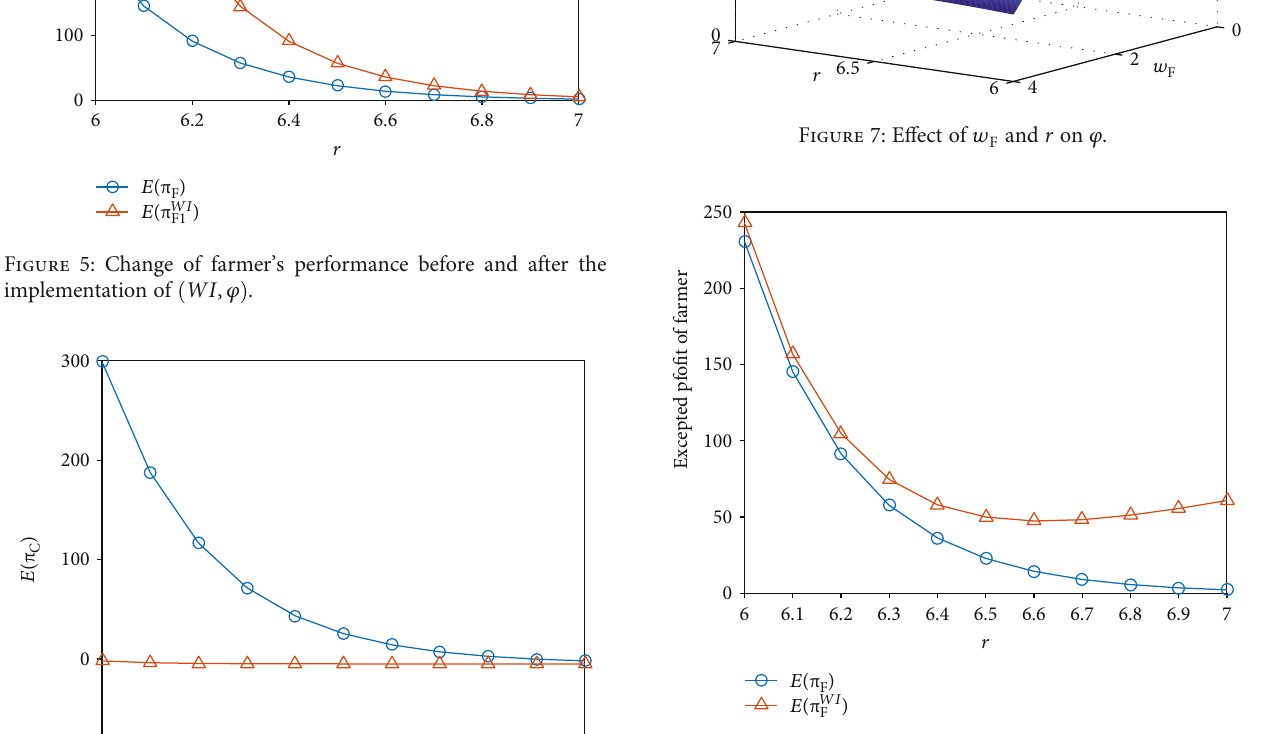
Figure 8: The farmer ’ s pro fi ts before and after the implementation of WI , φ , T